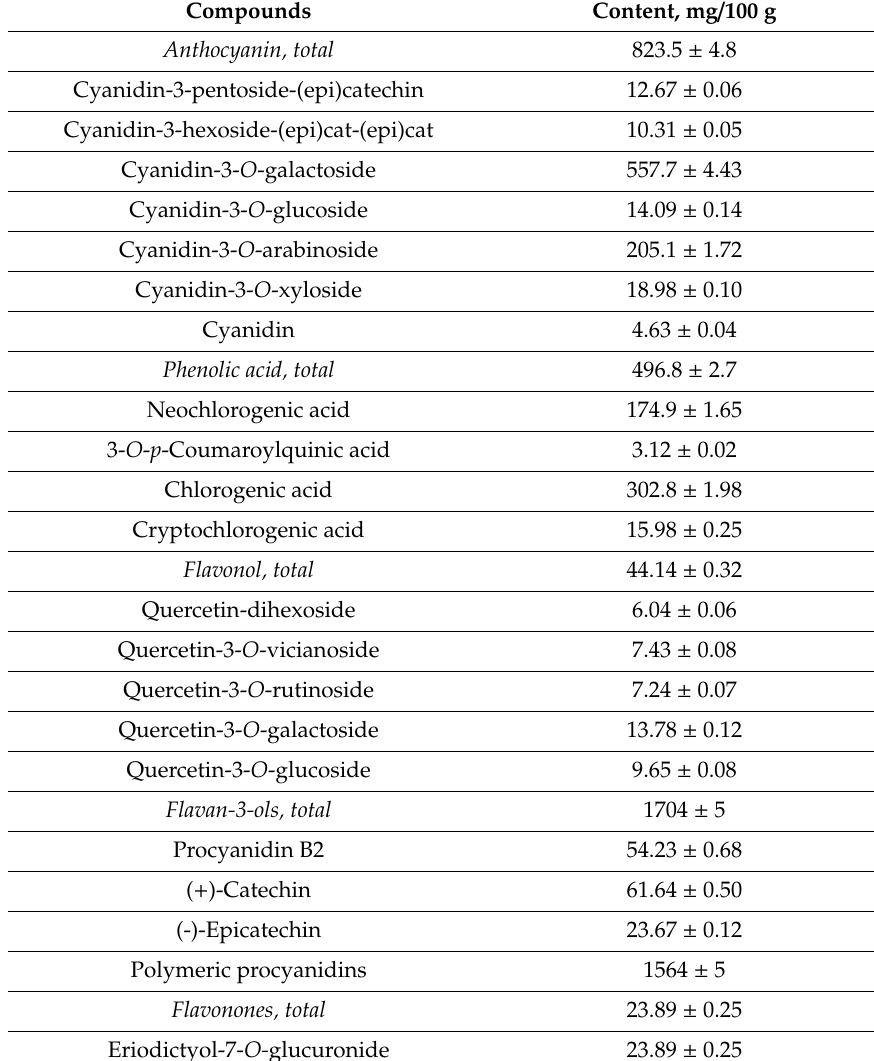
Table 2. Polyphenol composition (means ± SD from triple measurements) in chokeberry extract (mg / 100 g